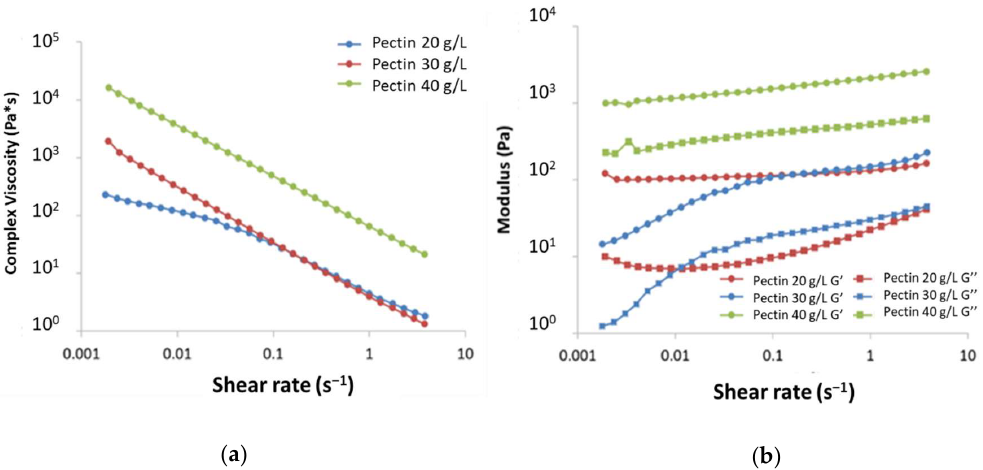
Figure 4. Rheological analysis of pectin gels. ( a ): complex viscosity ( η *); ( b ): storage modulus (G’) and loss modulus (G”) vs. shear rate of 20 g/L, 30 g/L, and 40 g/L LM pectin gels